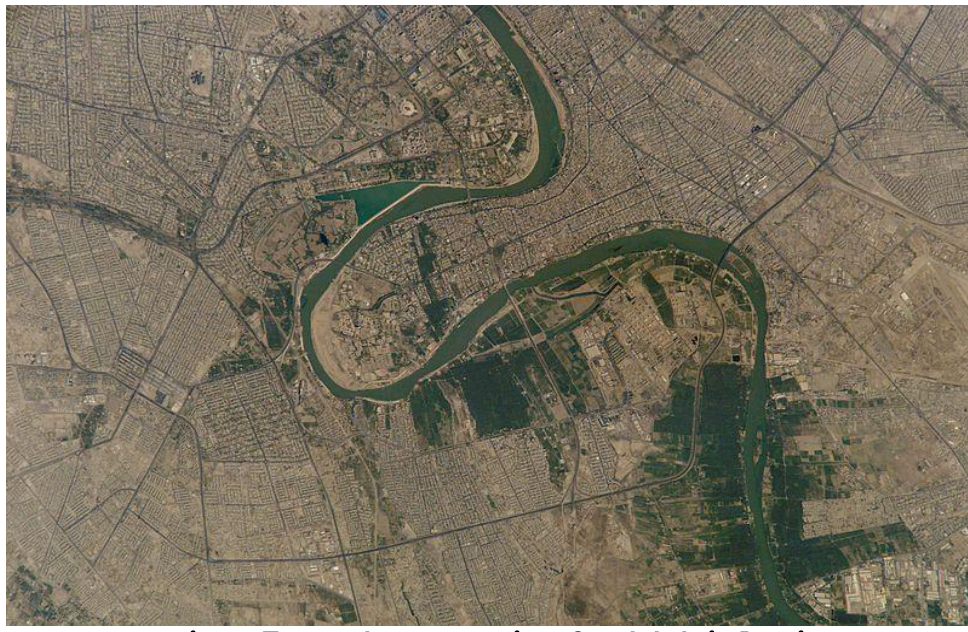
Fig. 2: Illustrated a center region of Baghdad city